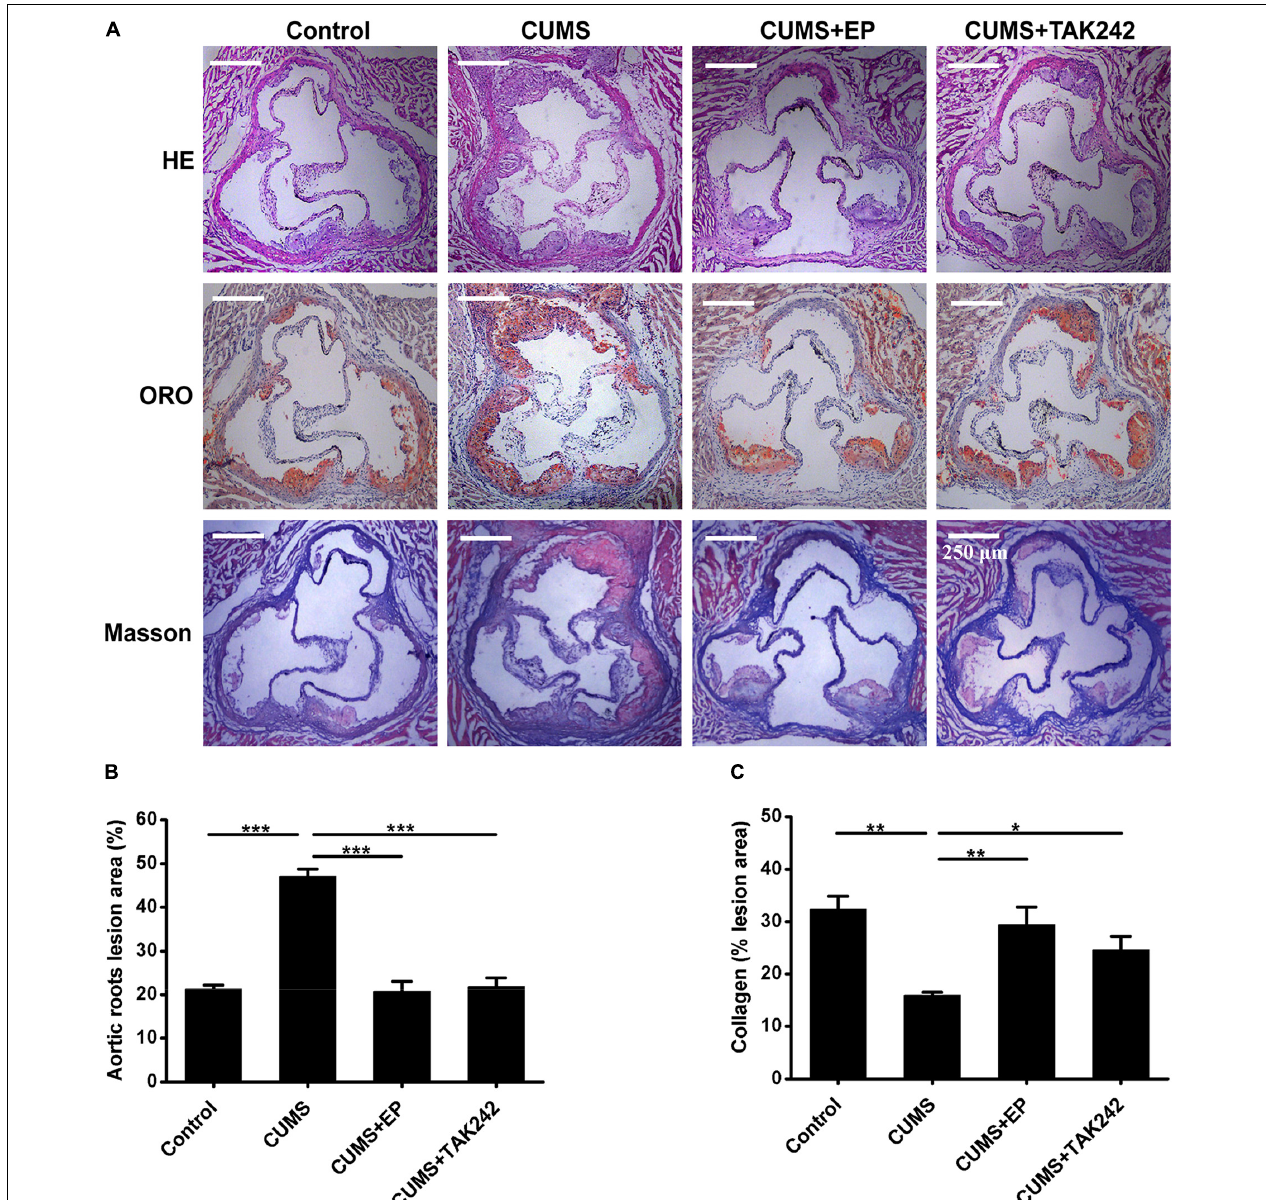
FIGURE 2 | Effect of EP and TAK-242 treatment on atherosclerotic lesions in CUMS ApoE − / − mice. Over a 16-week period treatment, the aortic root was harvested for analysis of atherosclerotic lesions. (A) Representative images of H&E, ORO (Oil Red O, ORO), and Masson staining of aortic sinuses. (B) Quantification of atherosclerotic plaque areas of aortic sinuses revealed that EP or TAK-242 treatment significantly decreased atherosclerotic lesions induced by CUMS ( n = 15). (C) Quantification of collagen fibers content of aortic sinuses ( n = 15). Data were expressed as mean ± SEM. Statistical analysis was performed by Student’s t -test or one-way analysis of variance. ∗ P < 0.01, ∗∗ P < 0.01, ∗∗∗ P <